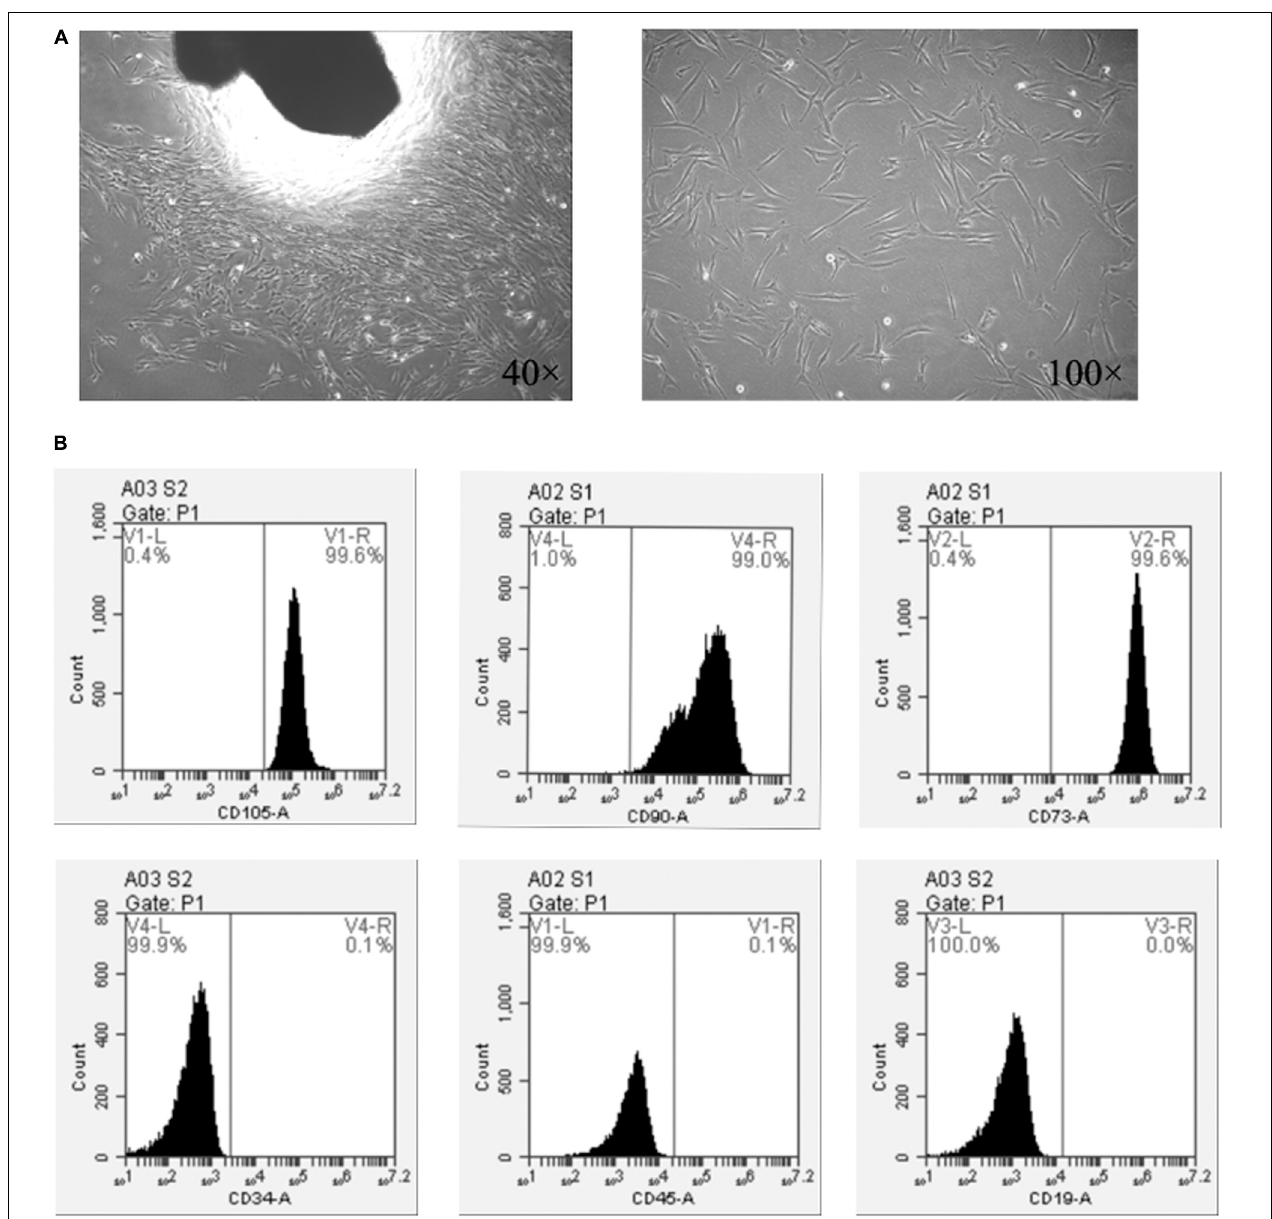
FIGURE 2 | SHEDs isolation and characterization. (A) Cell morphology at passage 0, and (B) expression of MSC surface markers on SHEDs as determined by flow